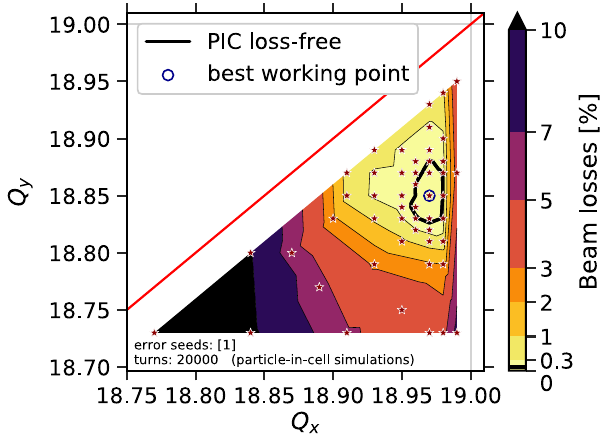
FIG. 9. Self-consistent PIC results for beam loss after 20 000 turns using the full field error model.